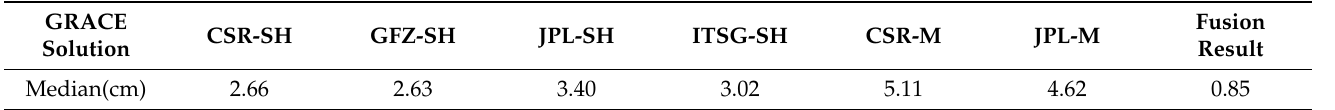
Table 1. Uncertainties of TWSC results derived from six GRACE solution and fusion result estimated by the GTCH method.